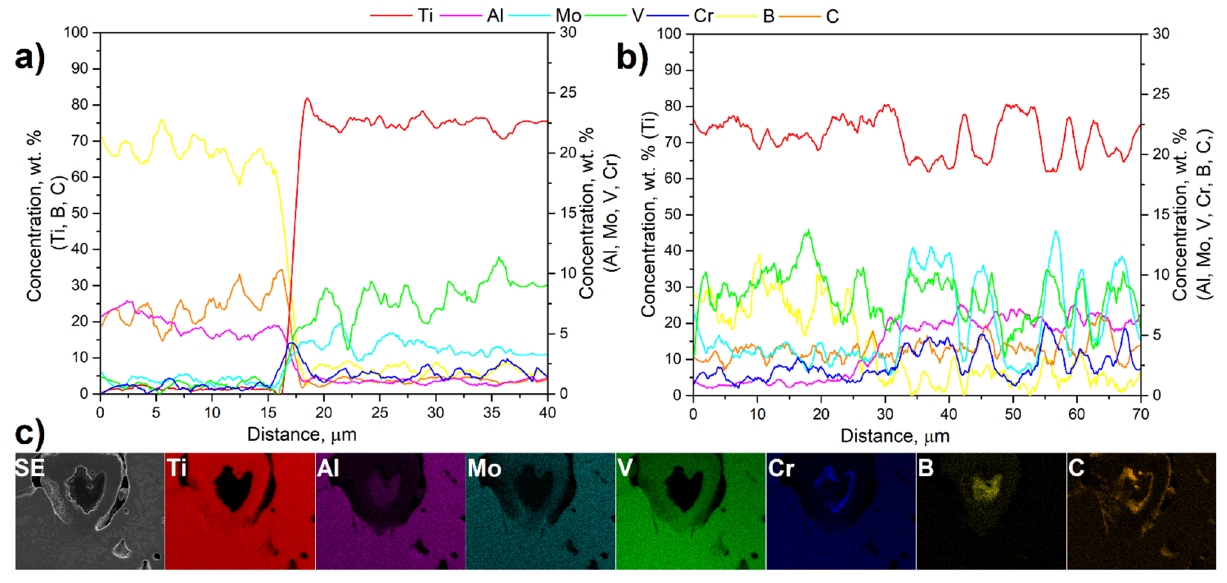
Figure 6. ( a , b ) EDS line-scan measurement results of Ti-5553 + 2% B 4 C composite corresponding to Figure 5d; ( c ) EDS mapping of unreacted B 4 C particle.